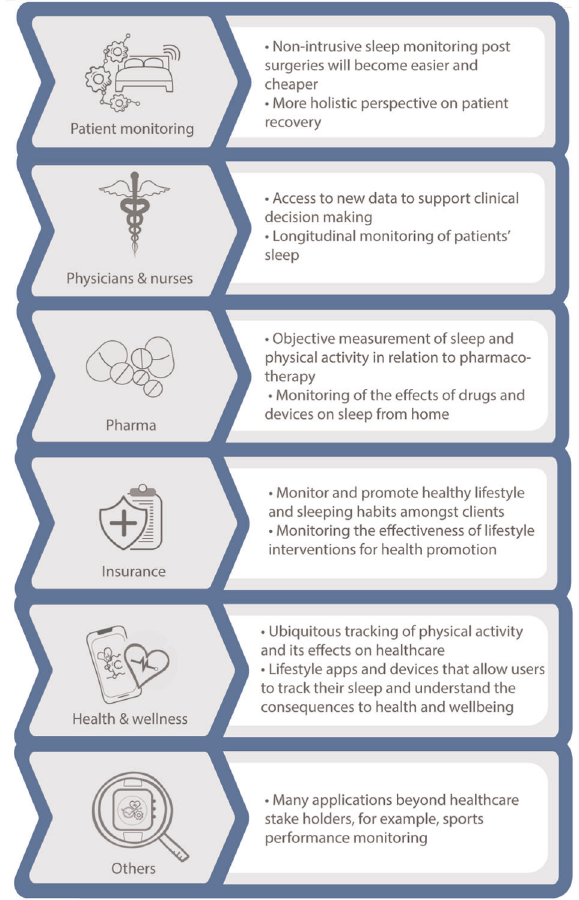
Fig. 7 Key areas of impact for sleep health. Emerging sleep health technologies will have an impact on patient monitoring, clinical care, insurance, the pharmaceutical industry and health and wellness applications, as well as other impacts including on digital therapeutics and sports